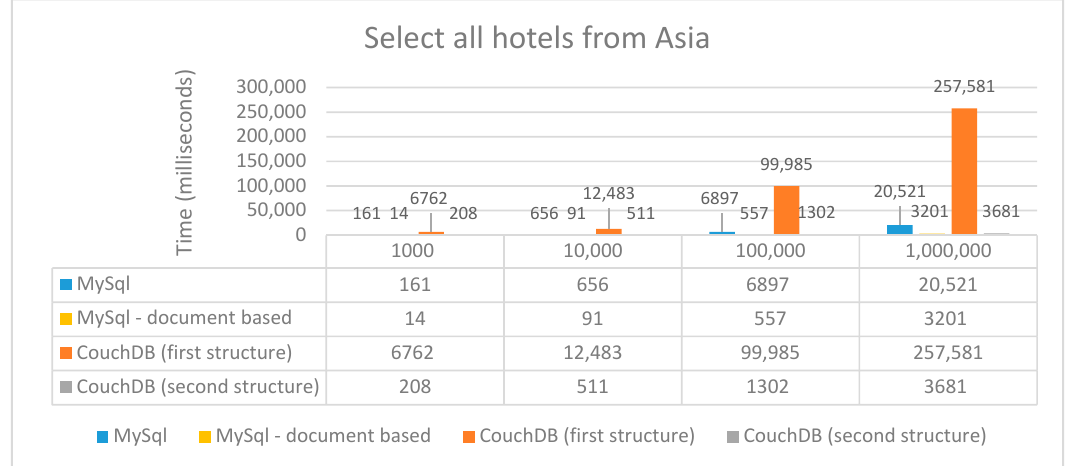
Figure 10. Performance time (ms) for select with three inner joins.